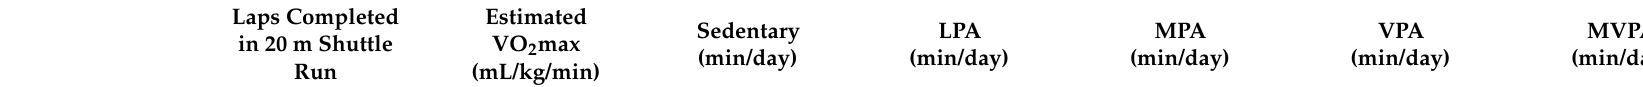
Table 3. Prediction of cardiovascular health risk markers with physical activity and cardiorespiratory fitness among South African